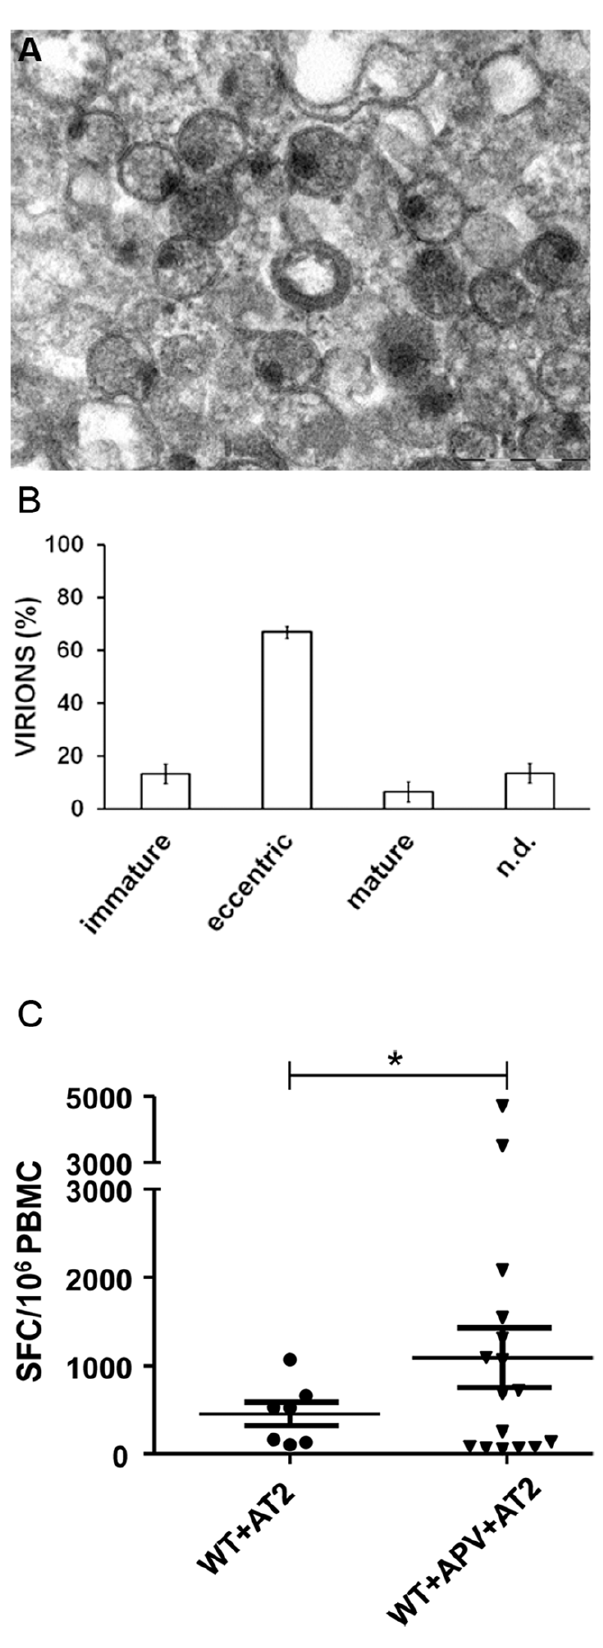
Figure 6. Immature NL4-3 virions improved the elicited cellular immune response. (A) Electron microscopy analysis of purified